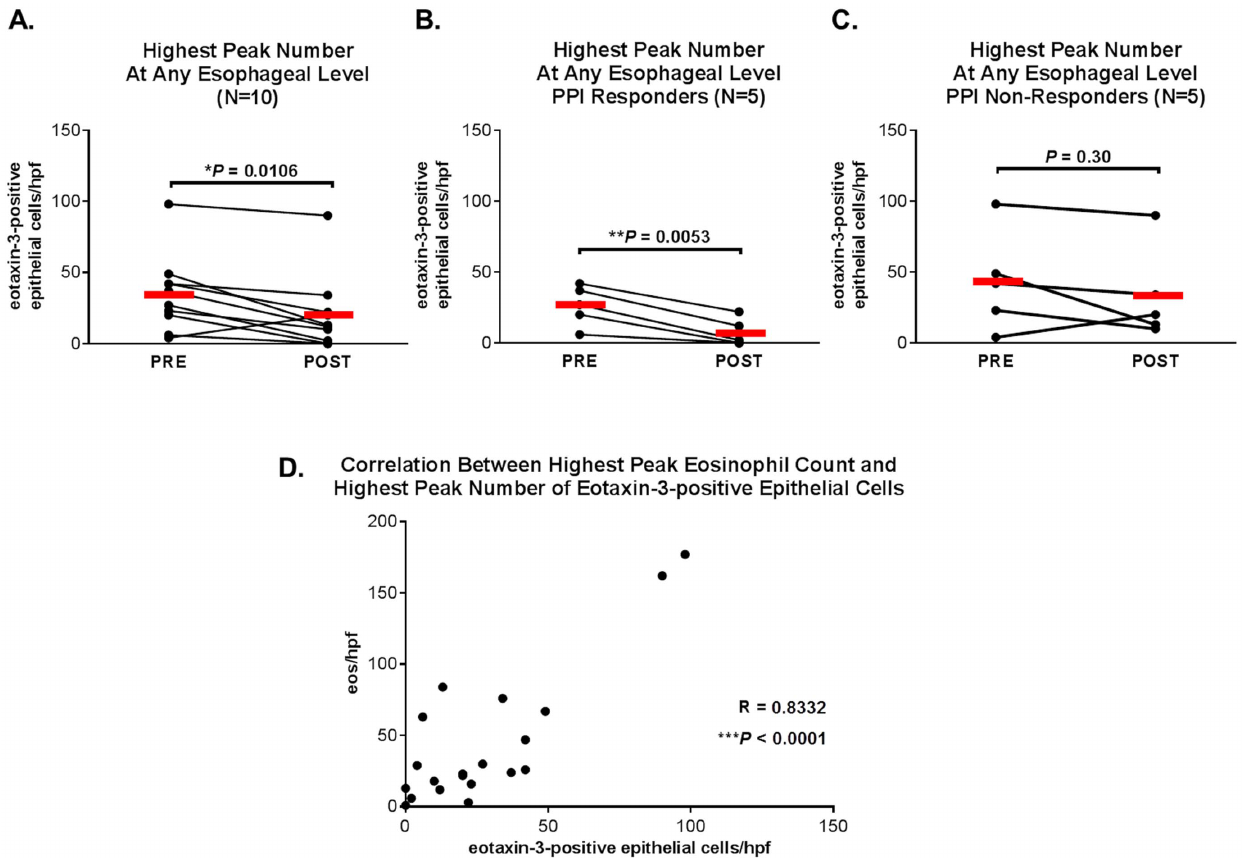
Figure 4. Highest peak number of eotaxin-3-positive epithelial cells at any esophageal level and correlation with highest peak eosinophil count. Highest pre- and post-PPI treatment peak number of eotaxin-3-positive epithelial cells in (A) all PPI-treated cases, (B) PPI responders, and (C) PPI non-responders. Red bars represent means. (D) Correlation between highest peak eosinophil count and highest peak number of eotaxin-3-positive epithelial